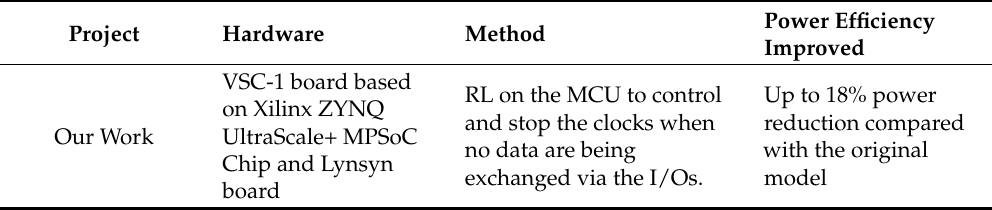
Table 4. Comparison of energy efficiency with similar